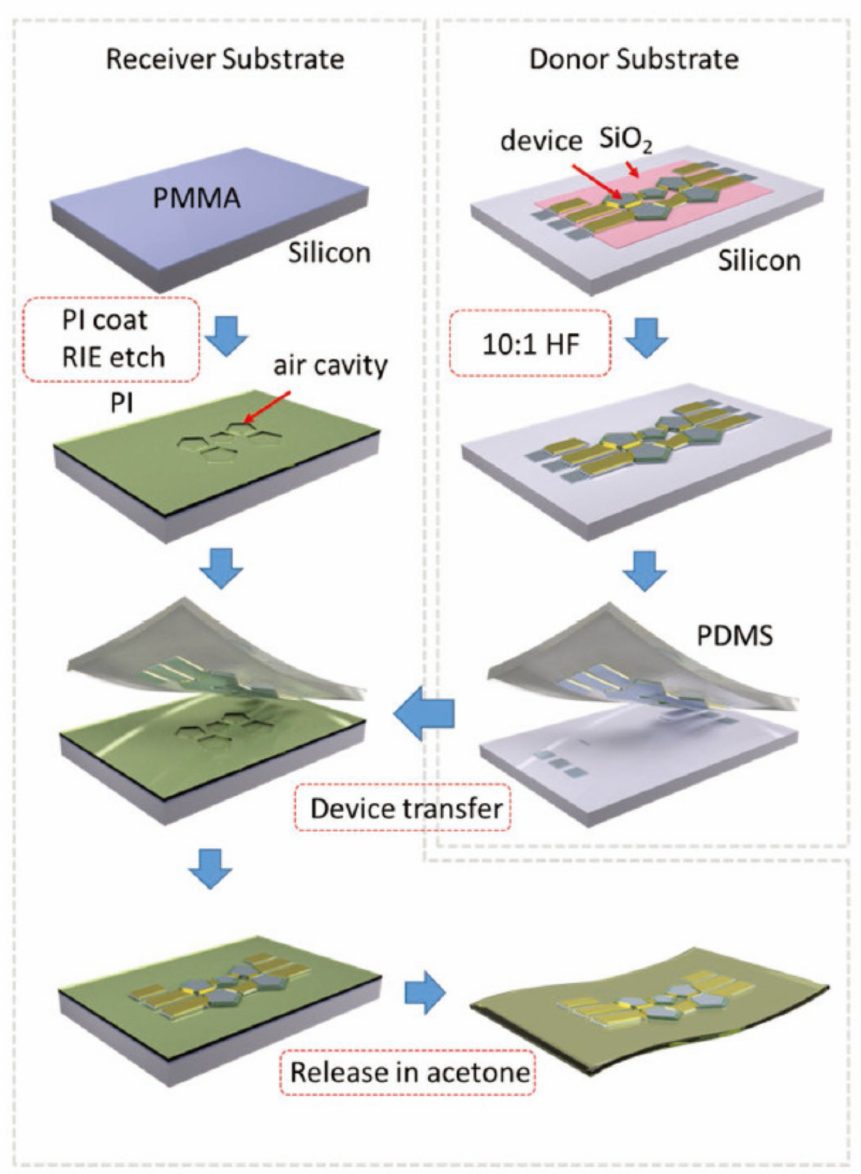
Figure 12. Transfer printing technology process flow for RF MEMS fabrication [98] Reprinted/adapted with permission from Ref. [98]. 2018, John Wiley and